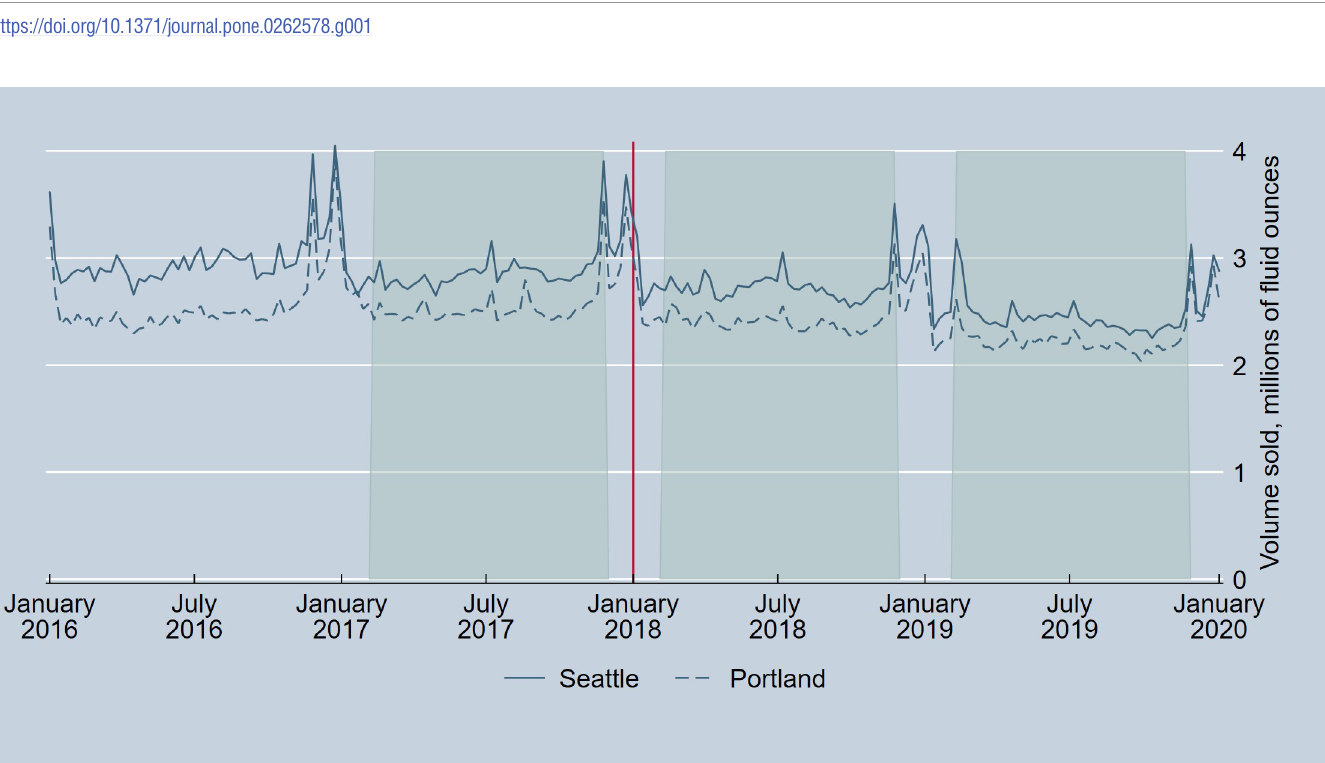
PLOS ONE | https://doi.org/10.1371/journal.pone.0262578 January 18, 2022 4 /